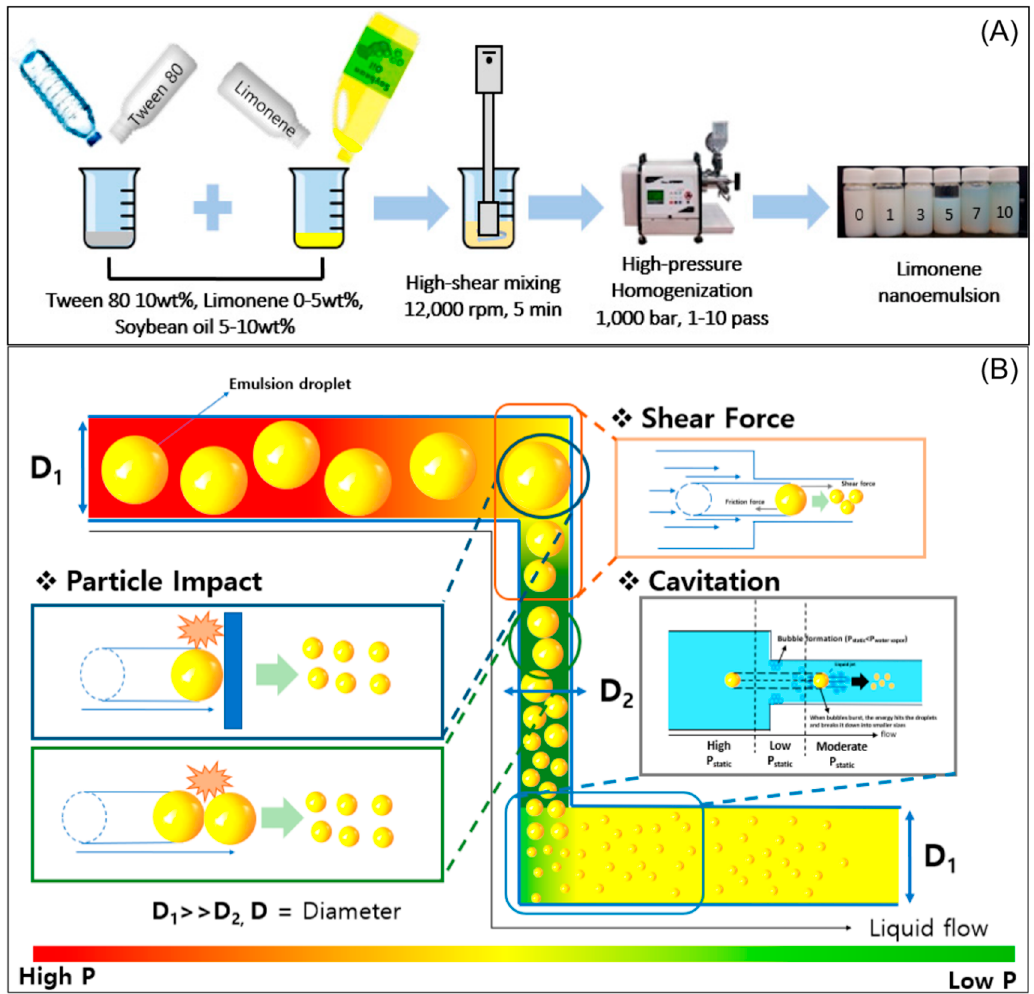
Figure 5. A simplified illustration of nanoemulsion preparation ( A ) and phenomena in the homogenization chamber ( B ). Reprinted from Hidajat et al. [29] with permission under the terms and conditions of the Creative Commons Attribution (CC BY) license (http://creativecommons.org/licenses/by/4.0/). Copyright (2020) the authors. Licensee MDPI, Basel,